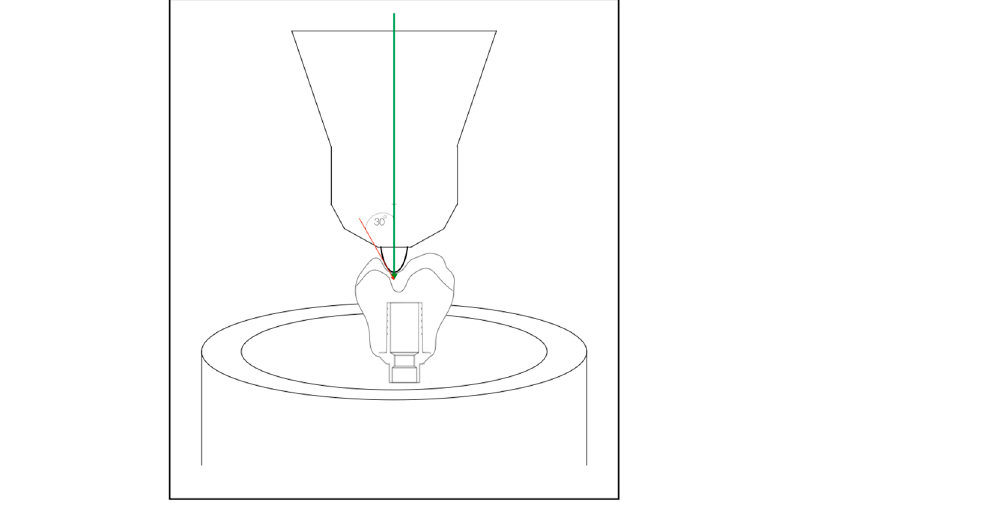
Figure 3. Dynamic loading with masticatory simulator scheme. Vertical stroke up: 2 mm, vertical stroke down: 2.5 mm, speed up: 60 mm/s, speed down: 20 mm/s, horizontal stroke: 0 mm, speed: 20 mm/s.